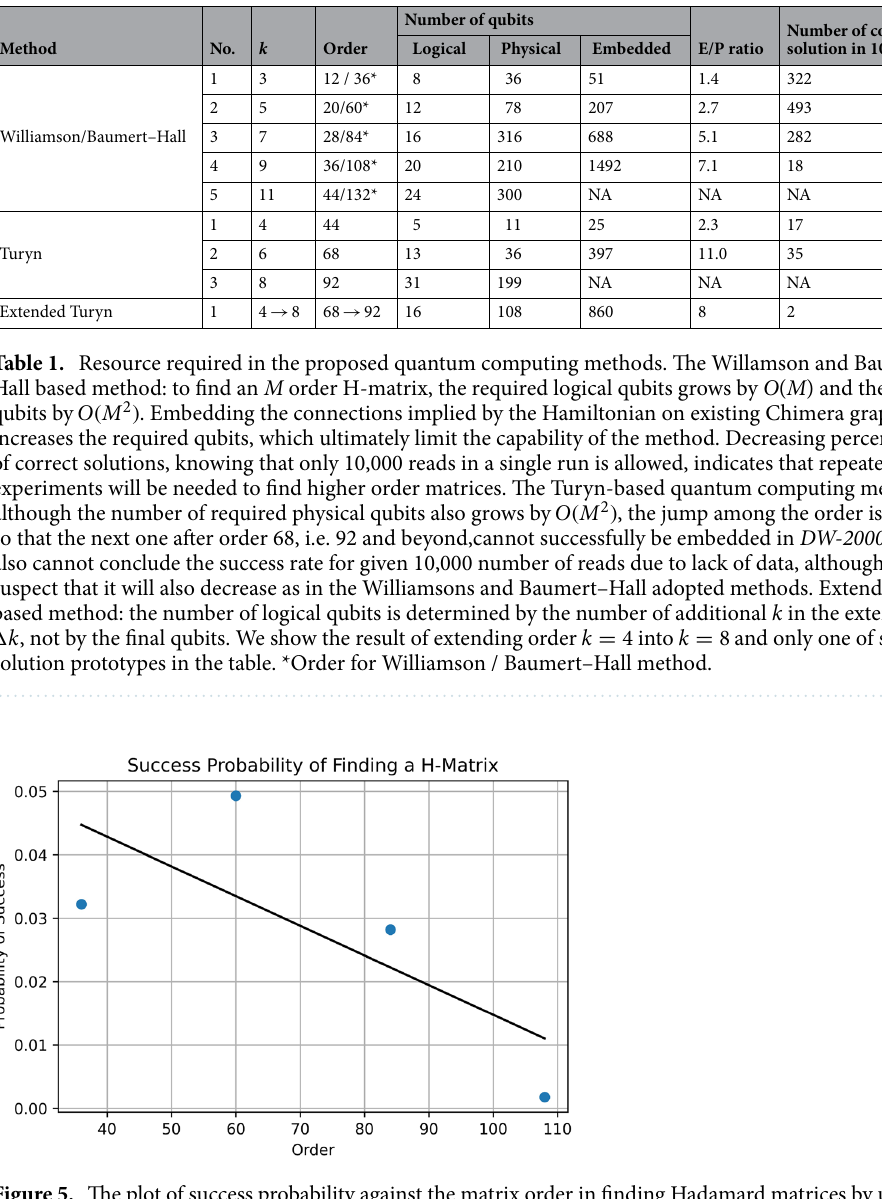
Figure 5. The plot of success probability against the matrix order in finding Hadamard matrices by using the proposed Baumert–Hall based quantum